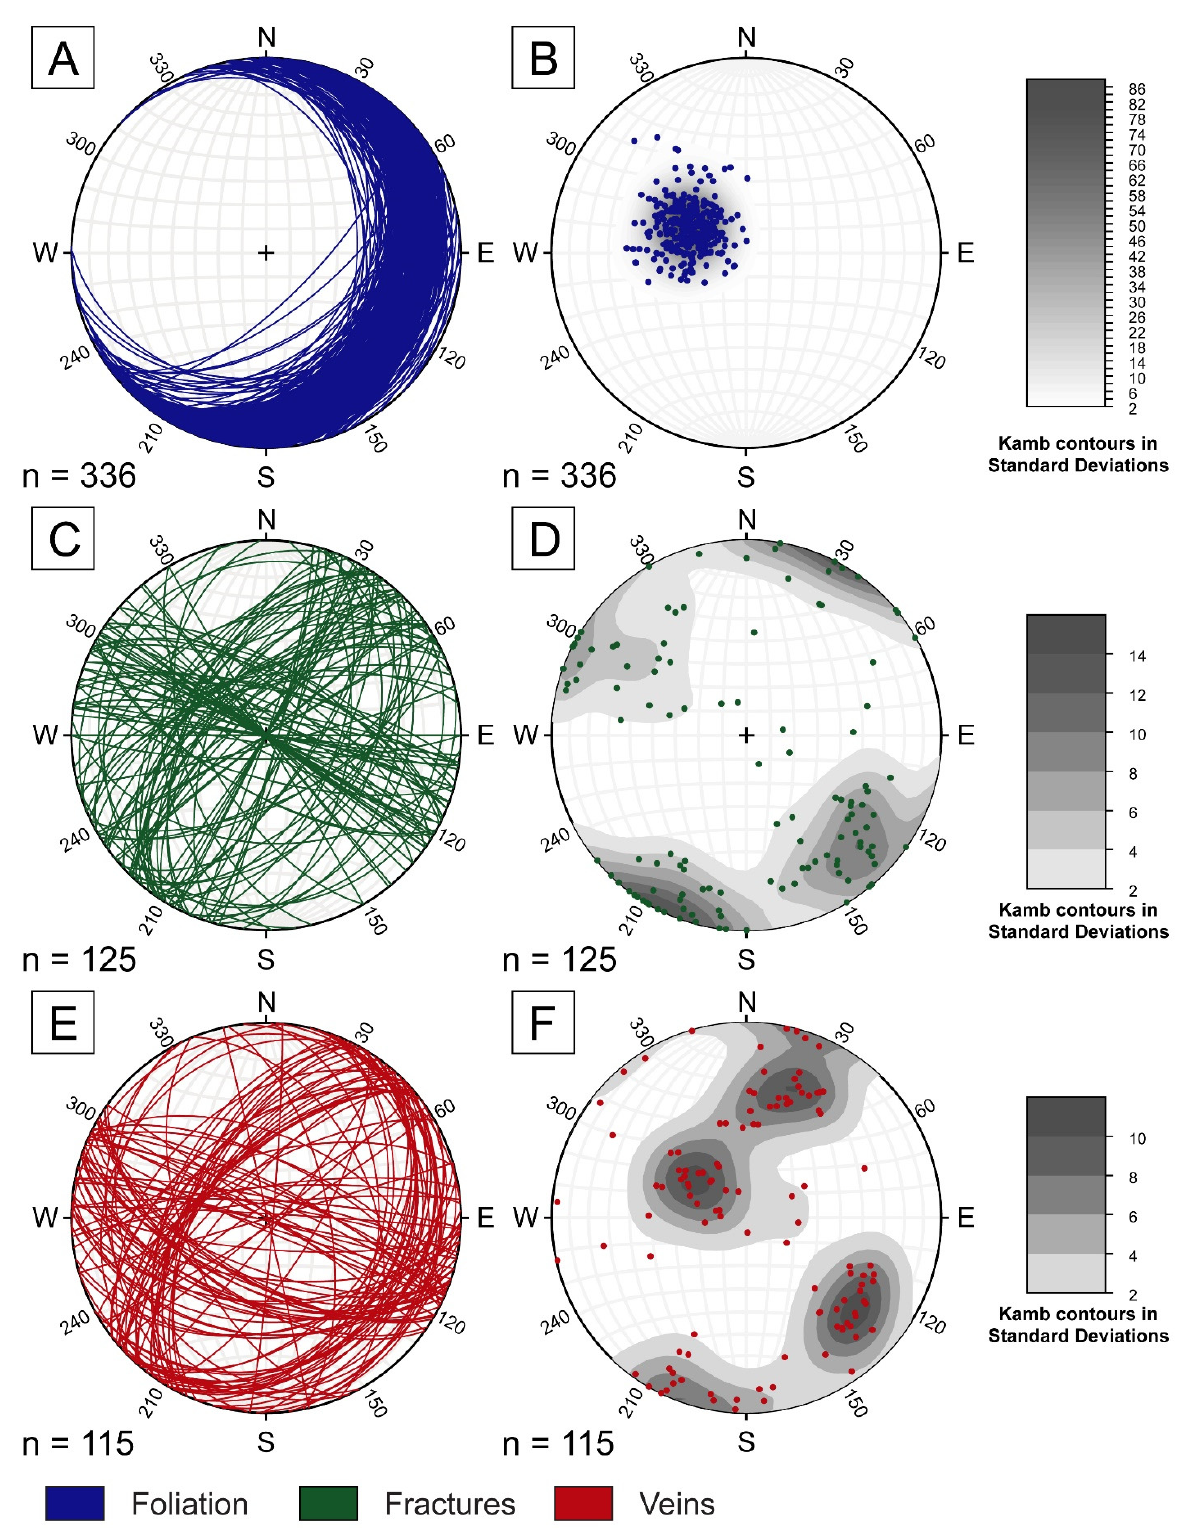
Figure 9. Planar and polar (pole-to-plane) plots with density contours of structures in the Glacier Creek area (field and drillhole data). ( A , B ) foliation; ( C , D ) fractures; ( E , F ) veins.